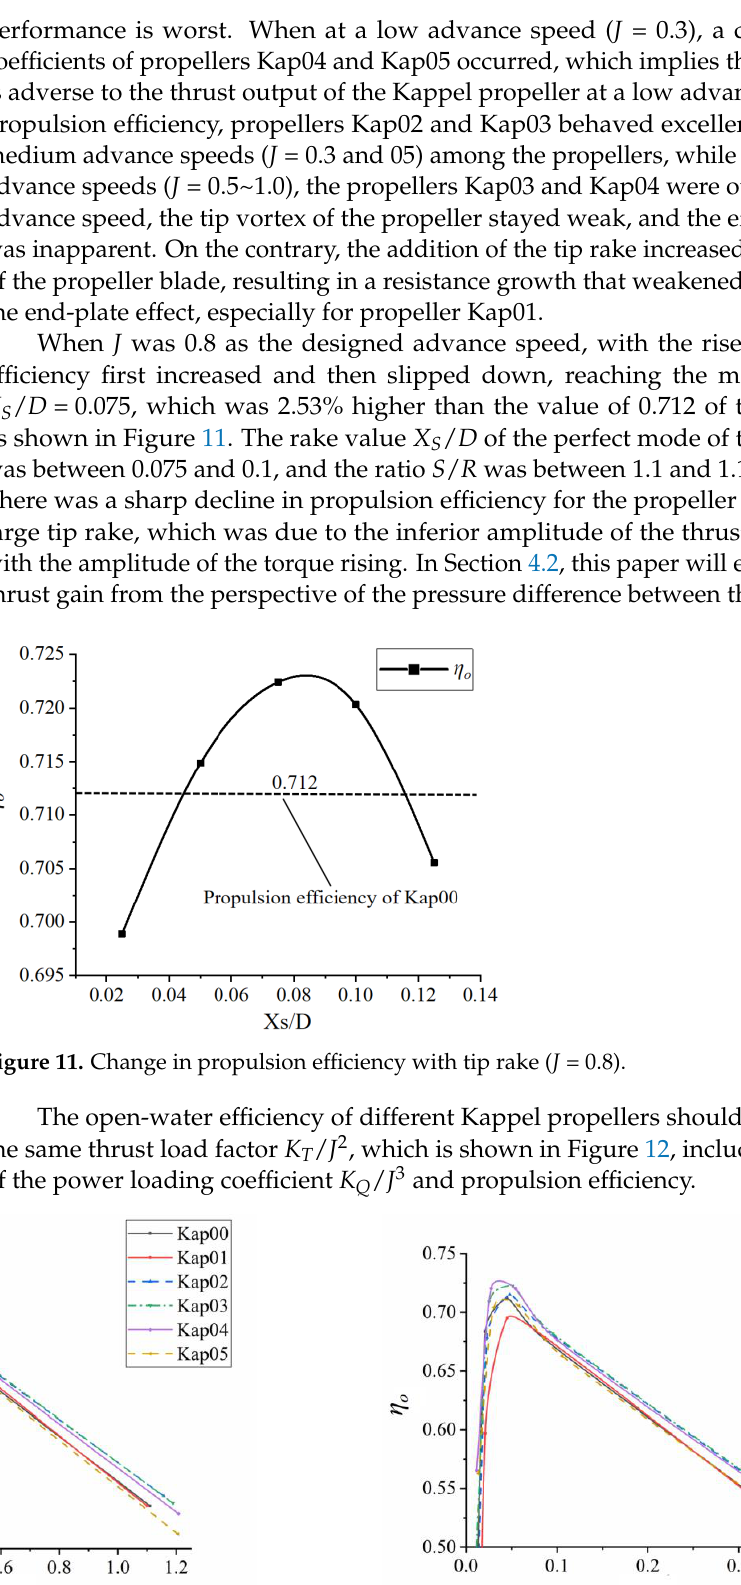
( b ) ( c ) Figure 10. Comparison of open-water performance of Kappel propellers with different tip rakes (12